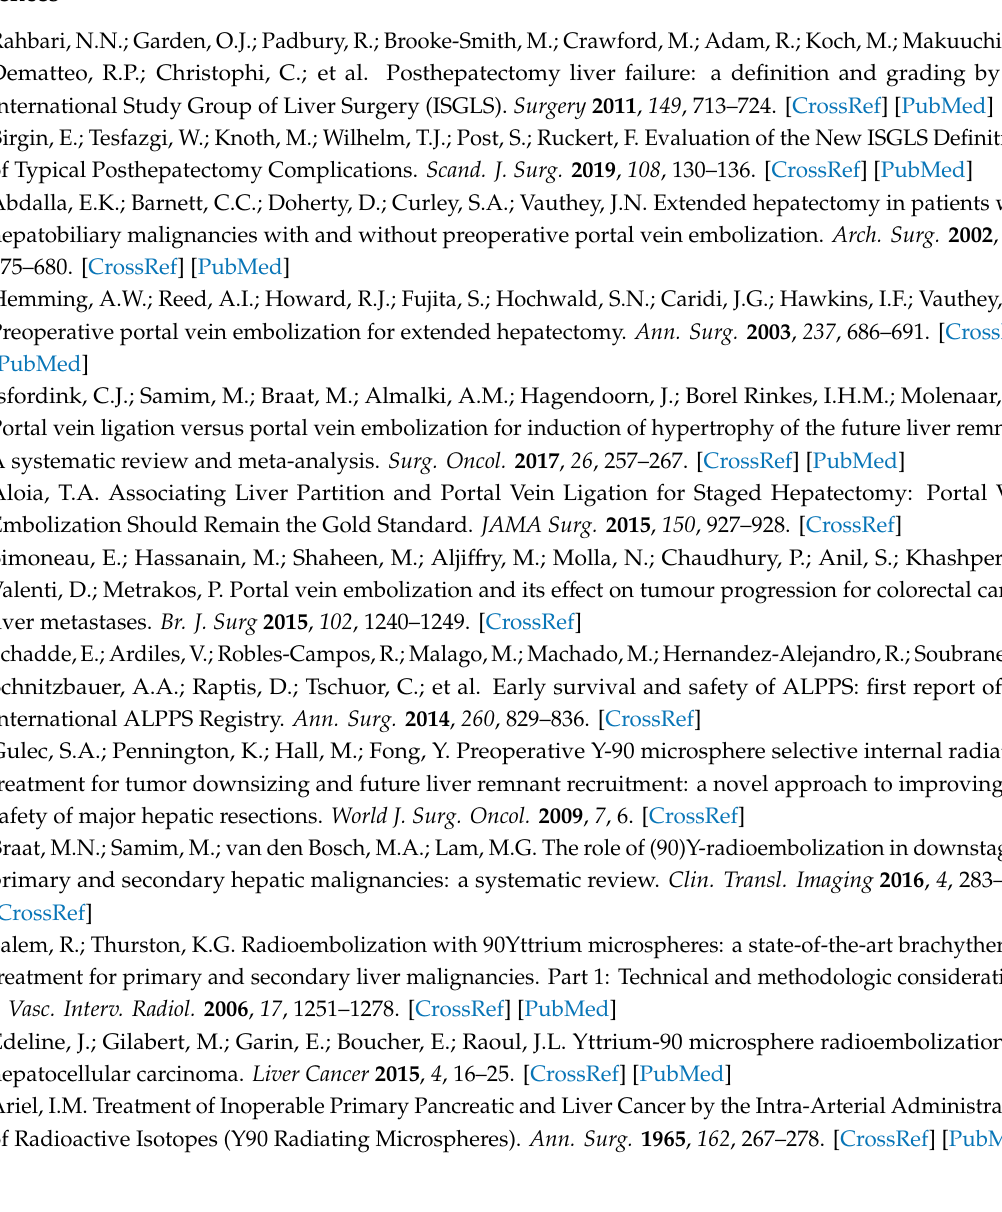
Table S1: Quality assessment of studies according to MINORS